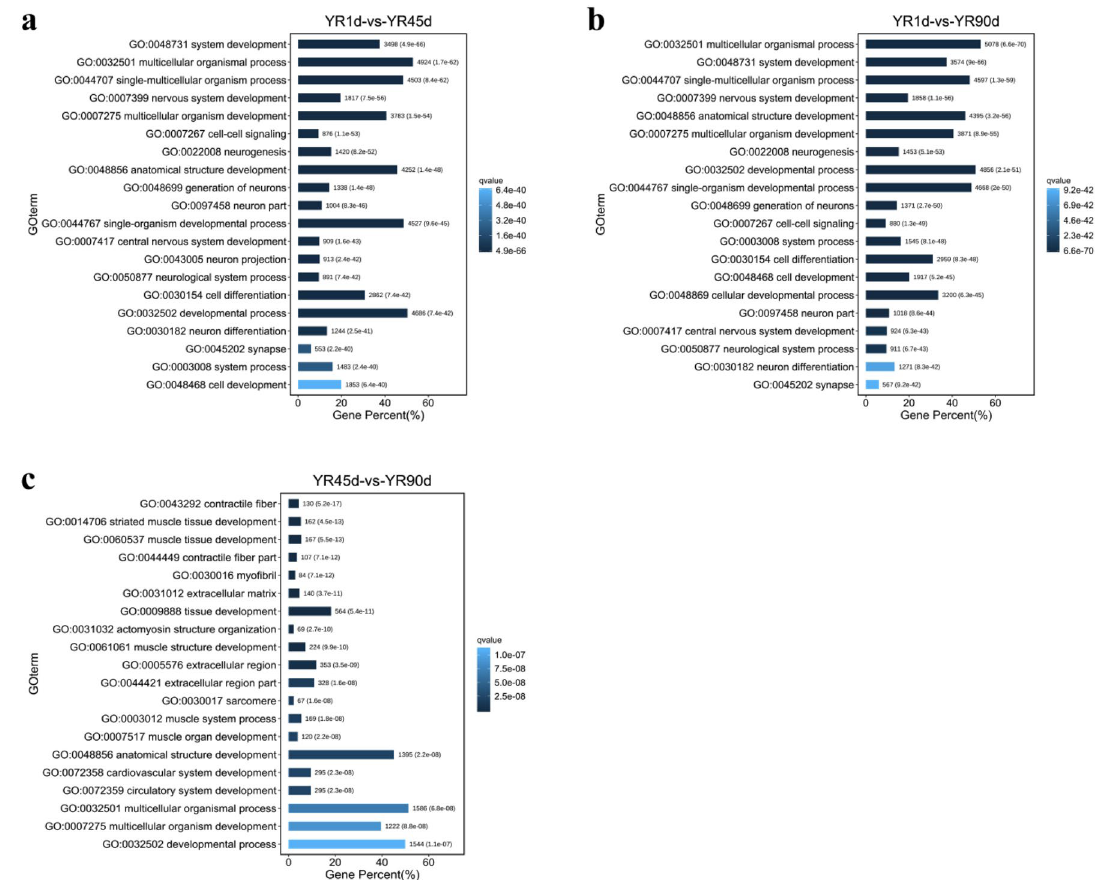
Figure 6. The top 20 GO terms among among the three compared groups. ( a ) YR1d vs. YR45d. ( b ) YR1d vs. YR90d. ( c ) YR45d vs. YR90d. Gene percent (%): the number of DEG in each term/the total of DEG